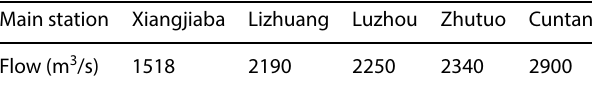
Table 4 Calculated flow from Xiangjiaba to